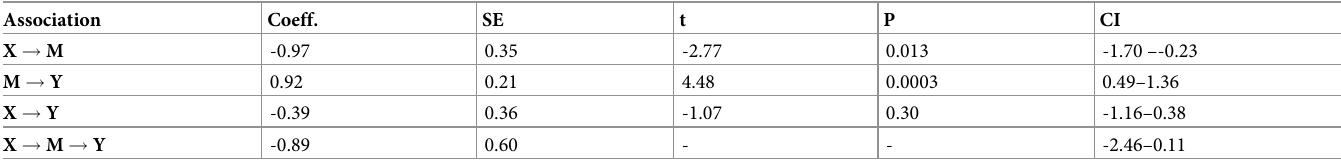
Table 4. Results of the mediation analysis. Association